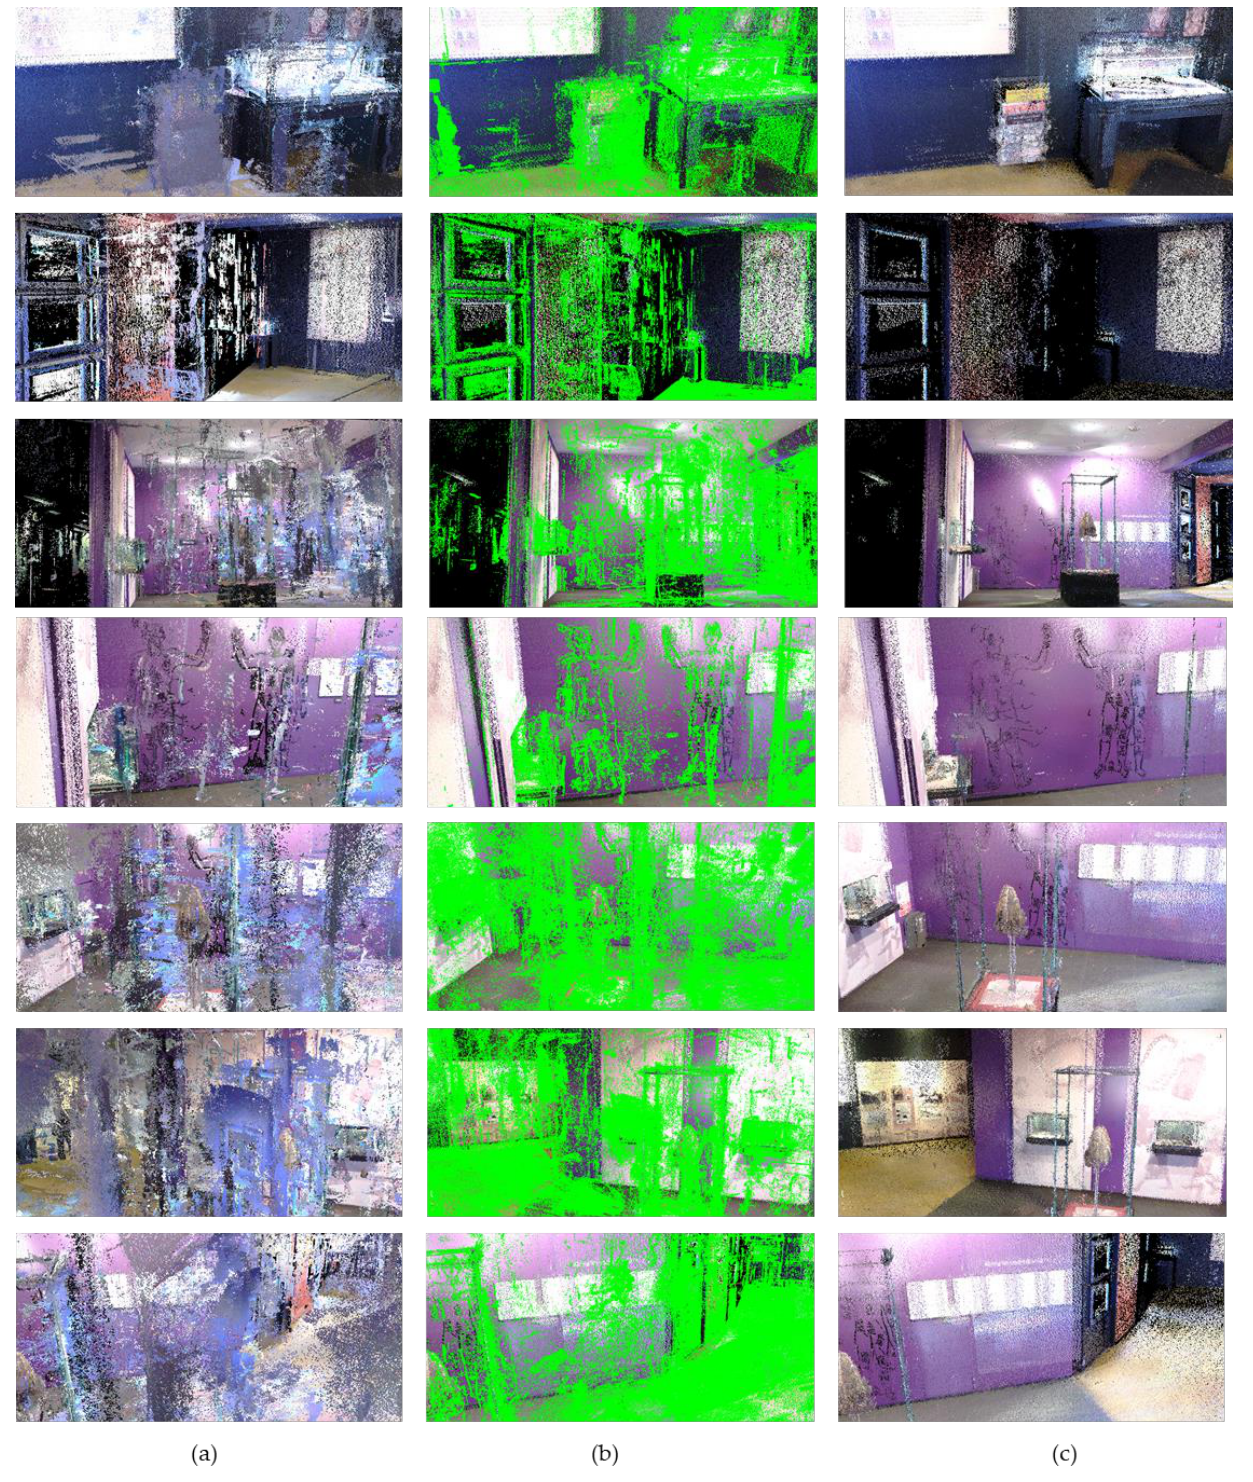
Figure 12. Results of the proposed method on another dataset. ( a ) is the original point cloud, ( b ) the green part of the figure is the noise region detected by our method, and ( c ) is the result of denoising using our method.